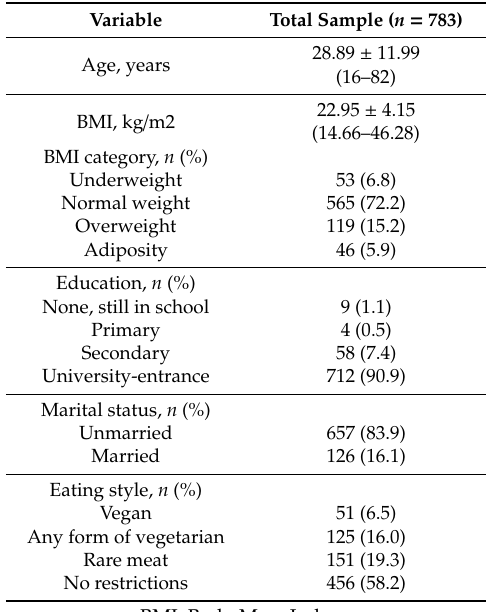
Table 1. Demographic characteristics of the study sample.